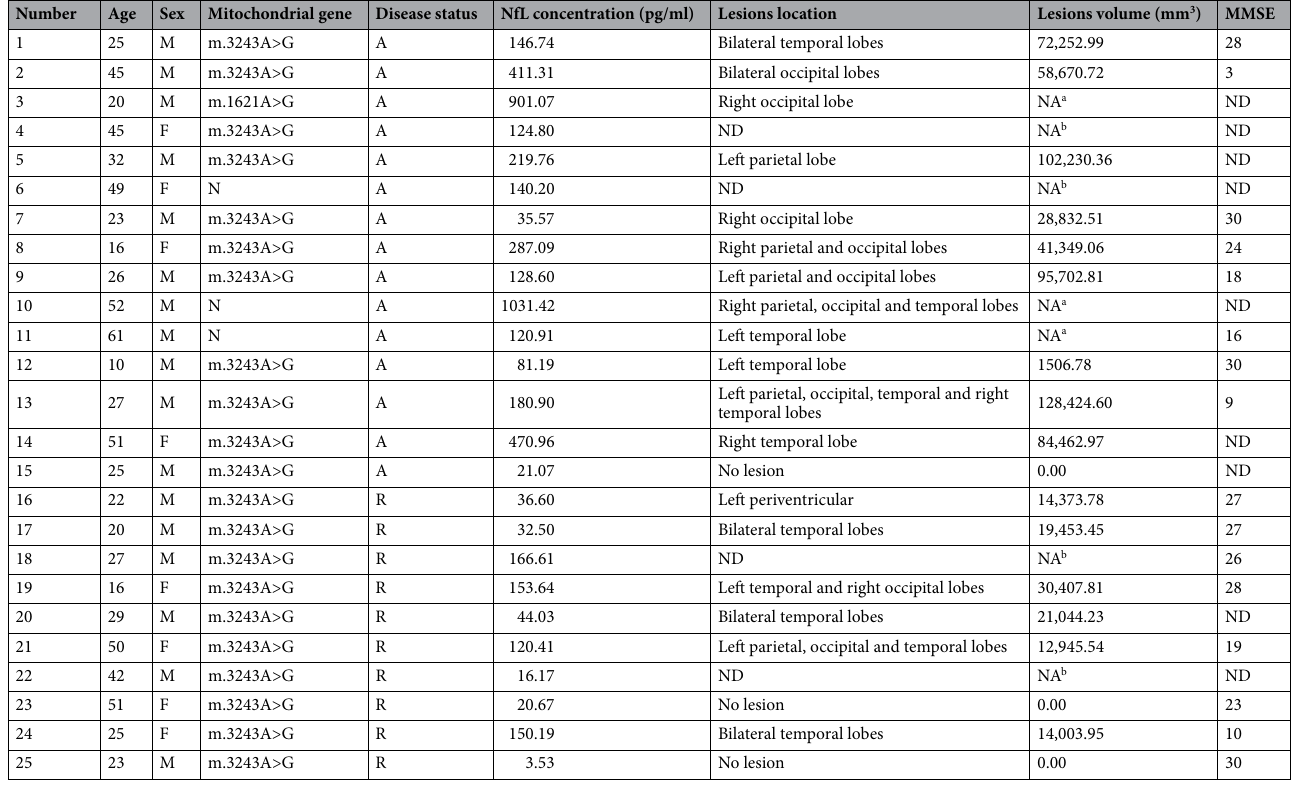
Table 1. Clinical characteristics of patients with MELAS. MELAS mitochondrial encephalomyopathy, lactic acidosis, and stroke-like episodes, NfL neurofilament light, lesions volume stroke-like lesions volume, M male, F female, A patients with MELAS in the acute attack phase, R patients with MELAS in the remission phase, ND not done, N negative, NA not available, MMSE Mini-Mental State Examination, a not performing multi- functional MRI, b not experiencing MRI.